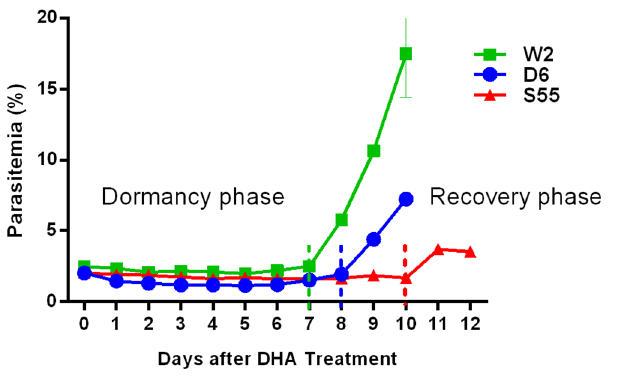
Fig 3. Dynamics of parasite density following DHA treatment of P . falciparum lines of W2, D6 and S55. Parasitemia are determined by SYBR Green staining and FACS analysis. Dotted lines indicate boundaries between dormancy and recovery phase in each parasite